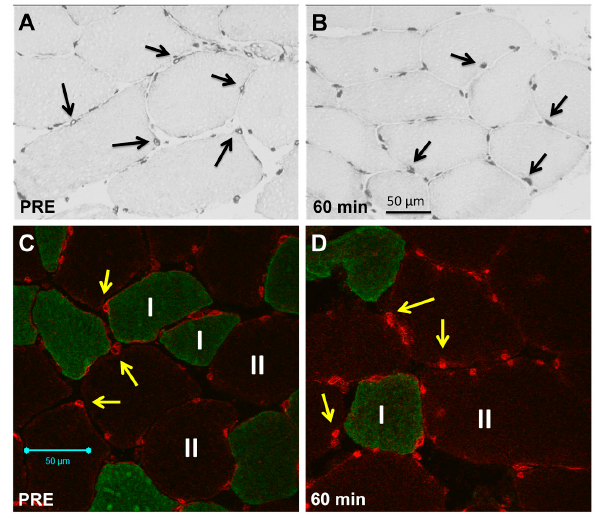
Figure 2. Immunohistochemical and immunofluorescence staining of SUMO-1 in skeletal muscle myofibres. ( A ) Diaminobenzidine (DAB)-stained consecutive cross-section showing nuclear and sarcoplasmic SUMO-1 staining in myofibres (200× magnification) under resting conditions (PRE) with lowered nuclear localization (black arrows indicating myonuclei with domiant perinuclear accumulation under baseline conditions); ( B ) DAB staining (200× magnification) of myofibres 60 min post resistance exercise (RE) showing increased nuclear accumulation of SUMO-1 (black arrows showing nuclei with increased intranuclear SUMO-1 localization); ( C ) Representative immunofluorescence staining of SUMO-1 in myofibre cross-sections under resting conditions (PRE) showing the preferential localization of SUMO-1 (Alexa 555, Red) at the nuclear envelope (yellow arrows) and in perinuclear regions of myofibres (MyHC I, Alexa 488, Green) (200× magnification); ( D ) Immunofluorescence staining (200× magnification) of myofibres 60 min post RE showing increased nuclear accumulation of SUMO-1 (Alexa 555, Red) and expanded SUMO-1 stained nuclear areas (yellow arrows).